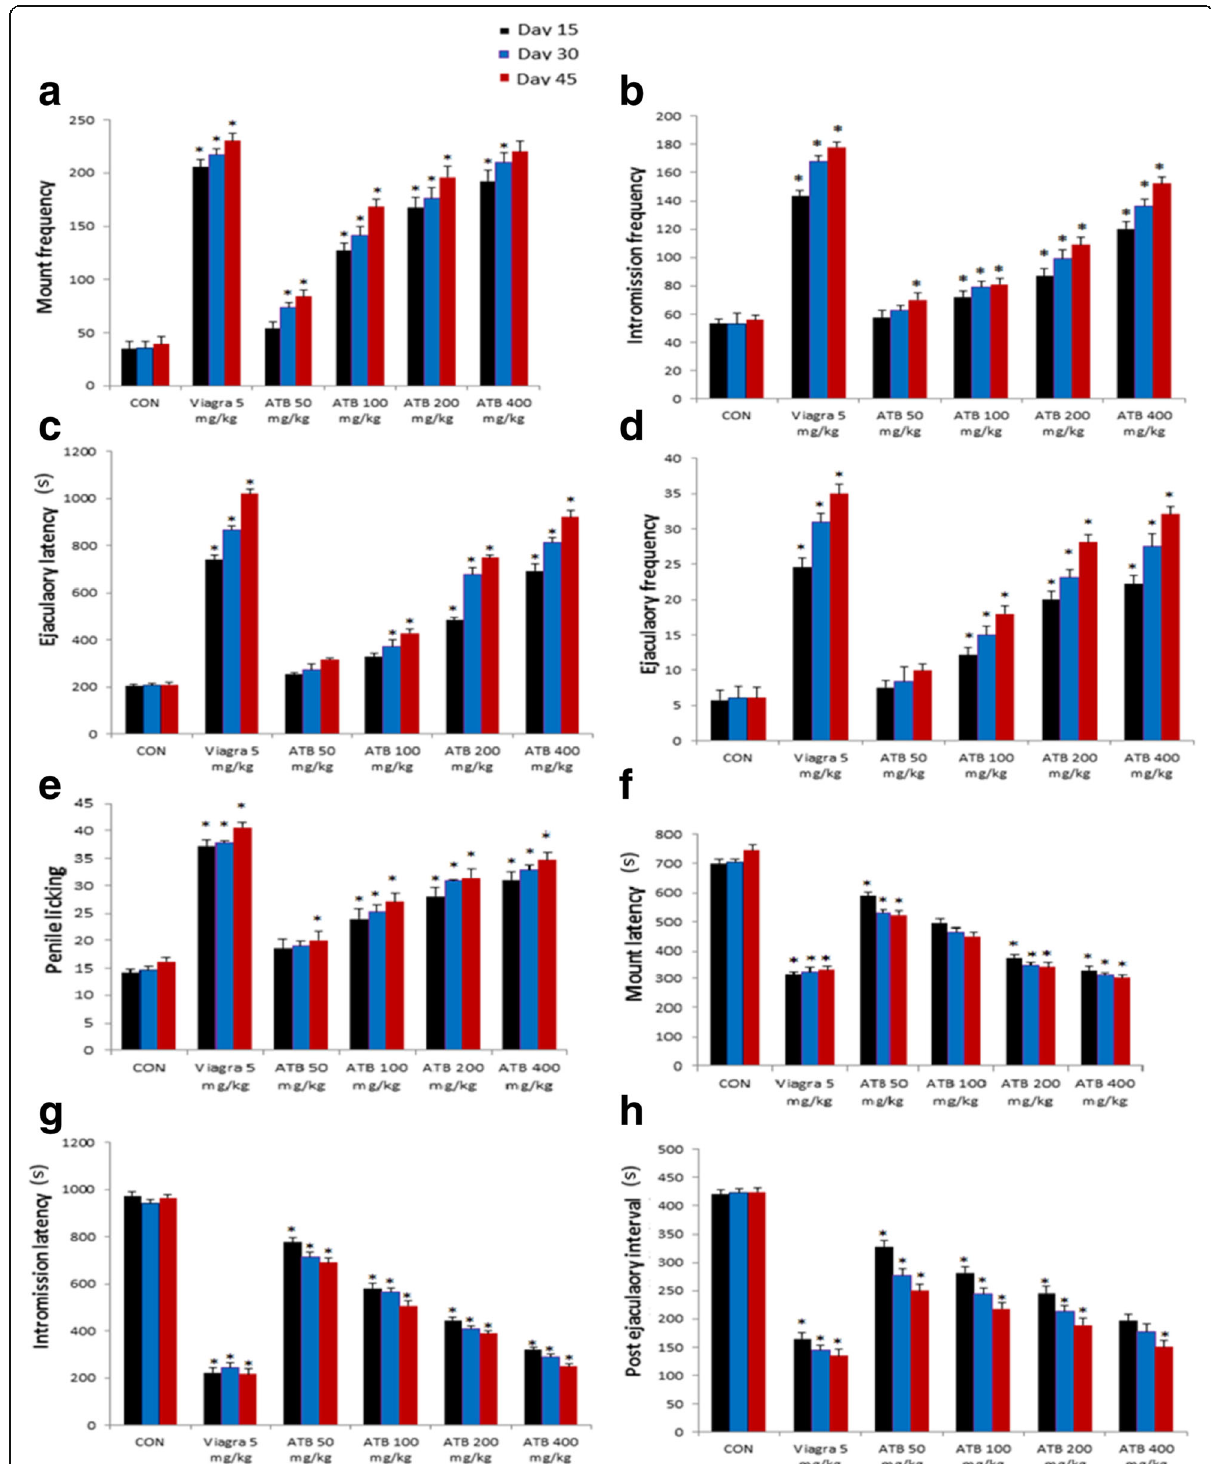
Fig. 2 Effect of ATB and Viagra on sexual behavior of rats; ( a ) Mount frequency, ( b ) Intromission frequency, ( c ) Ejaculaotry latency, ( c ) Ejaculatory frequency, ( d ) penile licking, ( f ) Mount latency, ( d ) Intromission latency and ( f ) Post ejaculatory interval. Data are expressed as mean ± SD ( n = 6), one-way ANOVA followed by Tukey test Post hoc analysis. * P < 0.05 as compared to control